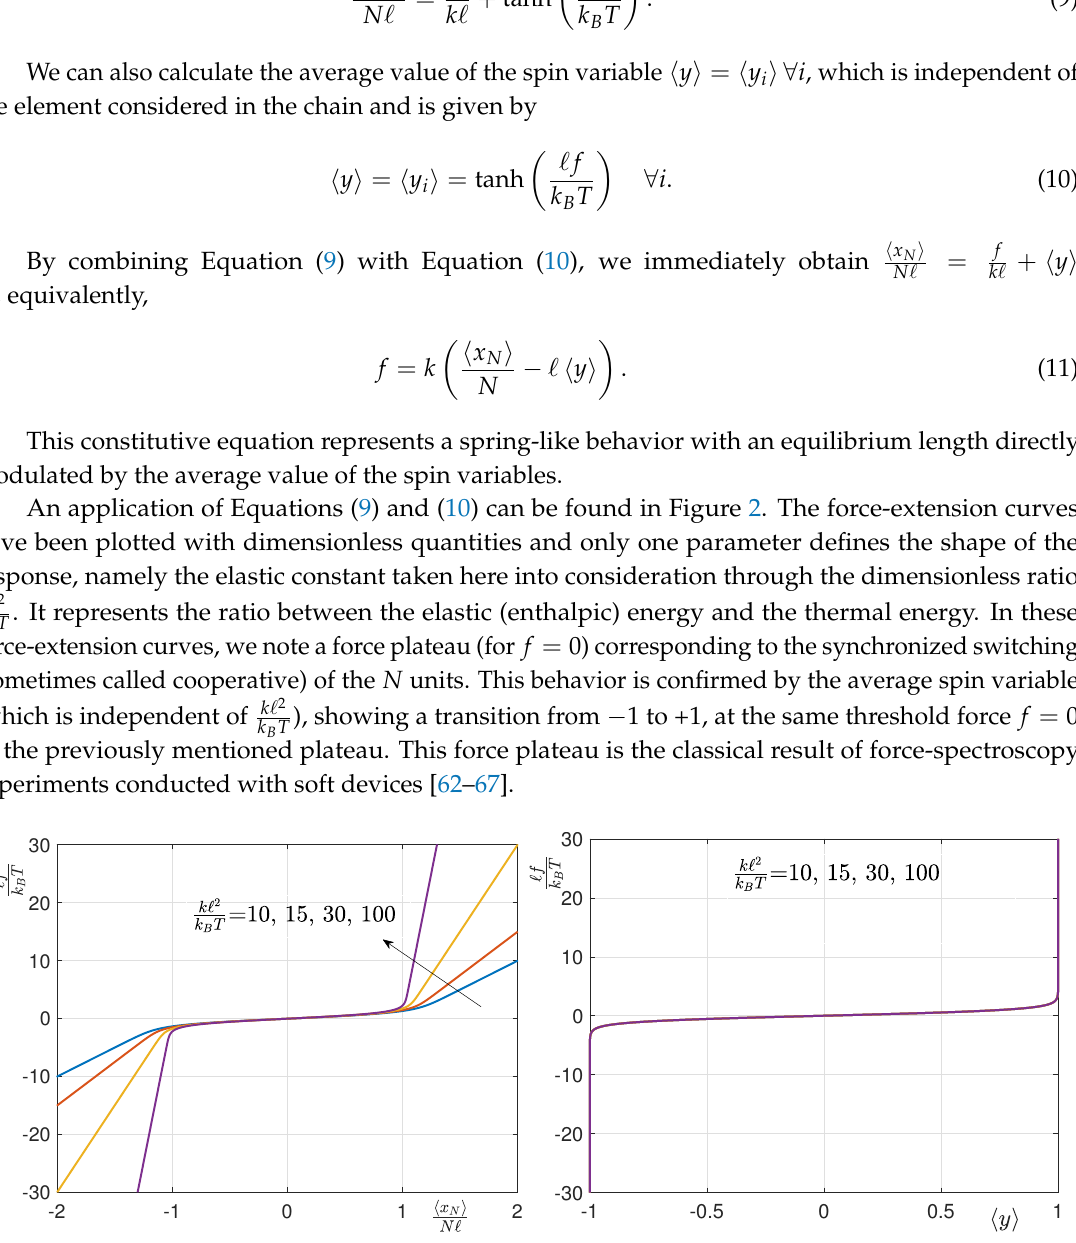
Figure 2. Average force-extension curves and average spin variables (plotted by means of dimensionless quantities) for the Gibbs ensemble with N = 5 and k (cid:96) 2